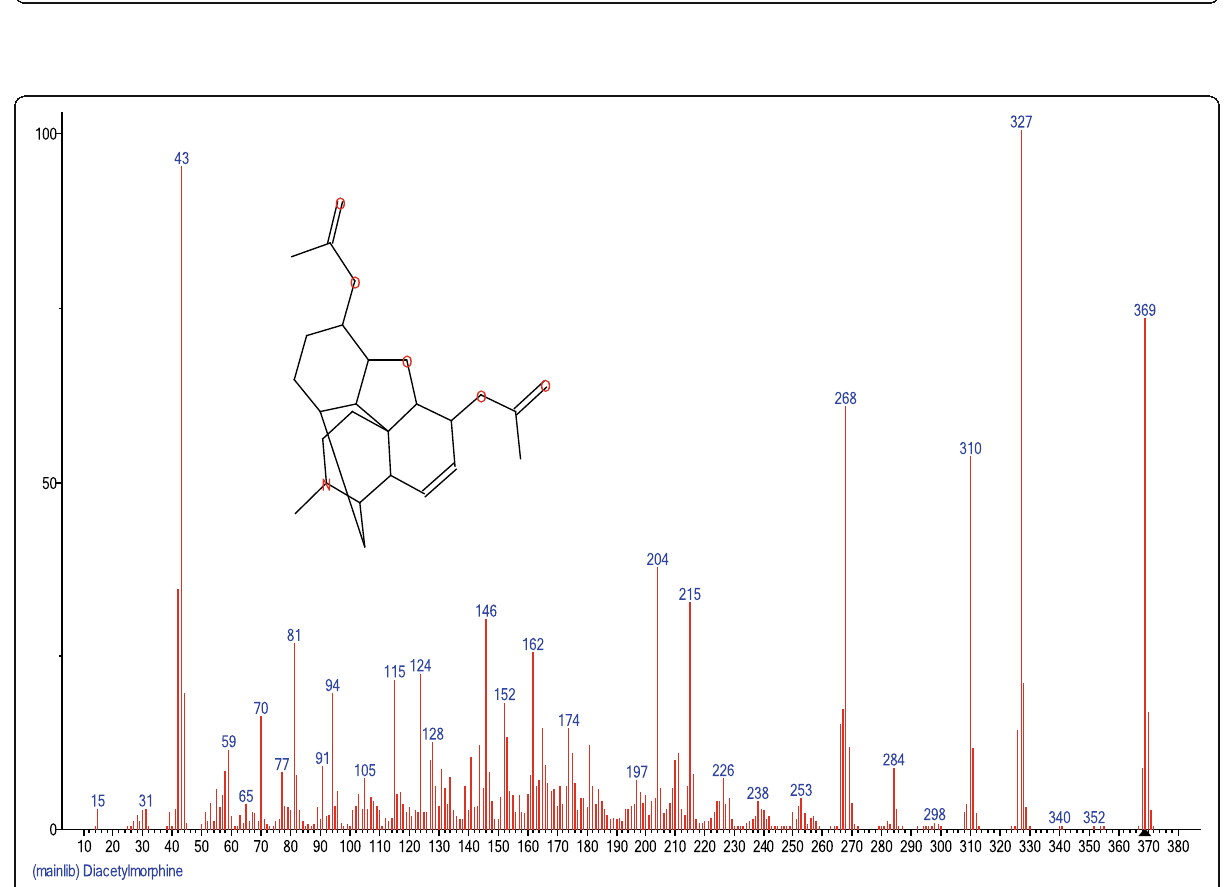
Fig. 3 Mass spectral characteristics of Tryptophan 2,4-dimethoxy-5-ethoxyamphetamine in the third instar larvae of L. cuprina after hydrolysis